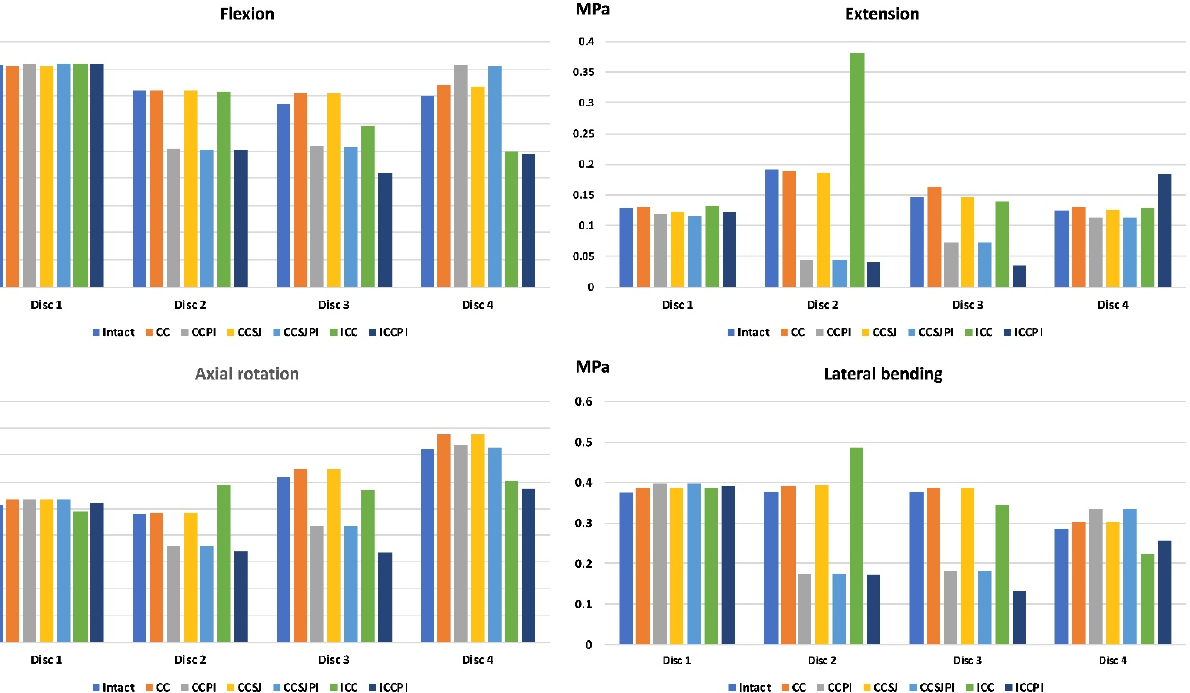
Figure 8. The results of the annular ground substance stress.